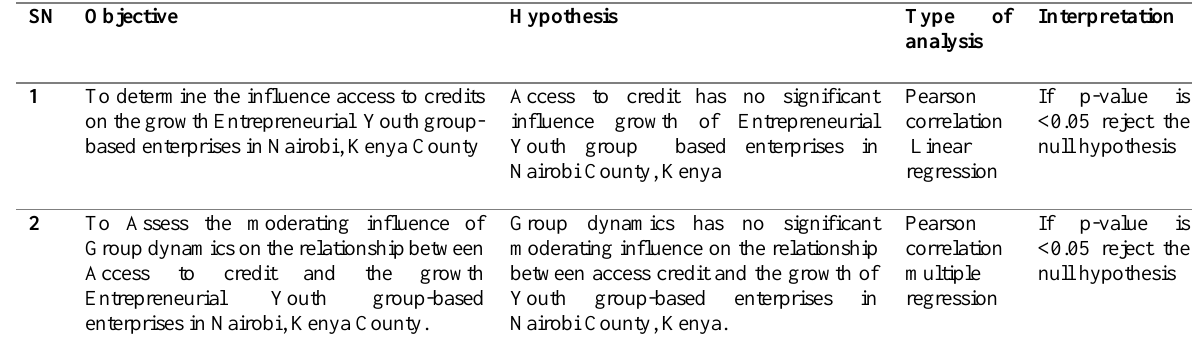
Table 1: Objective and